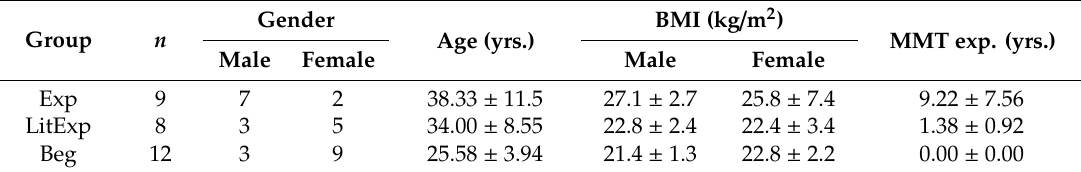
Table 1. Anthropometric data and years of test experience (MMT exp.) sorted by groups into experienced (Exp), little experienced (LitExp) and beginners